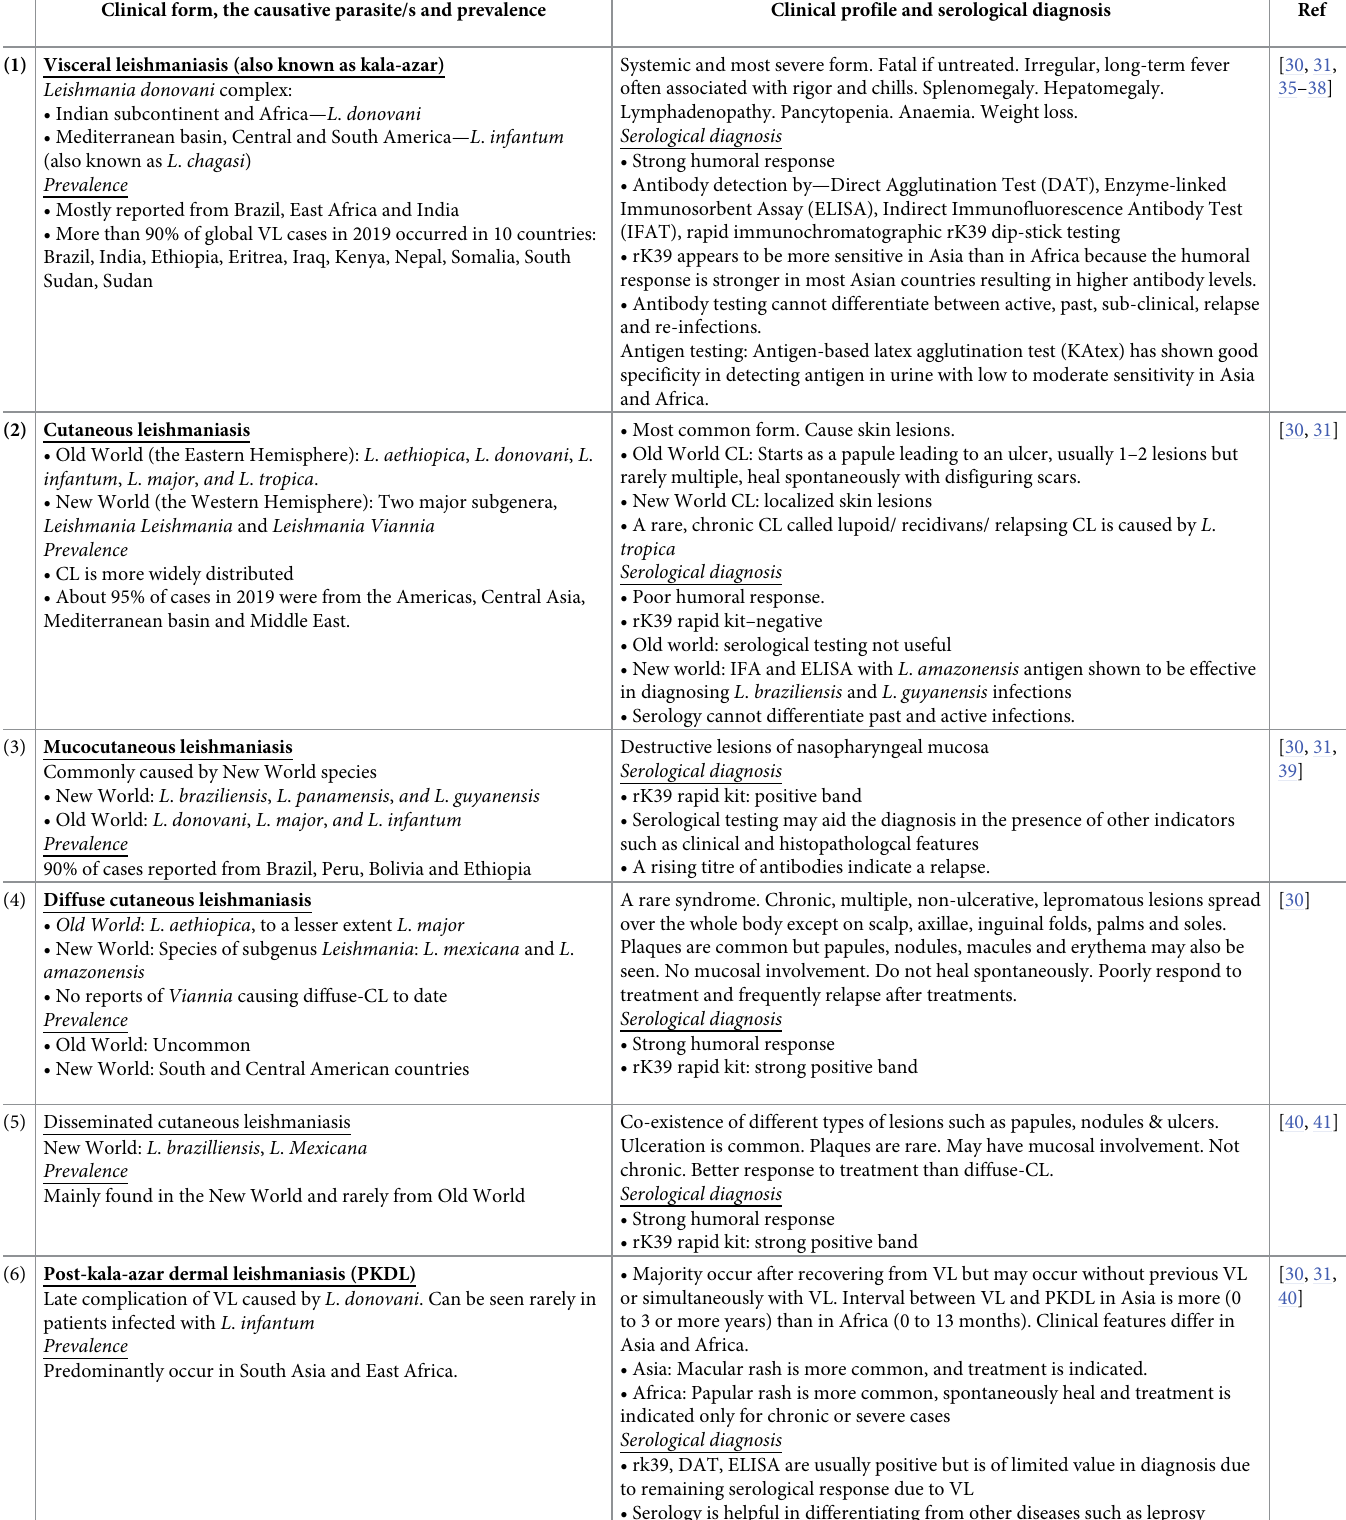
Table 4. Characteristics of common clinical forms of Leishmaniases. Clinical form, the causative parasite/s and